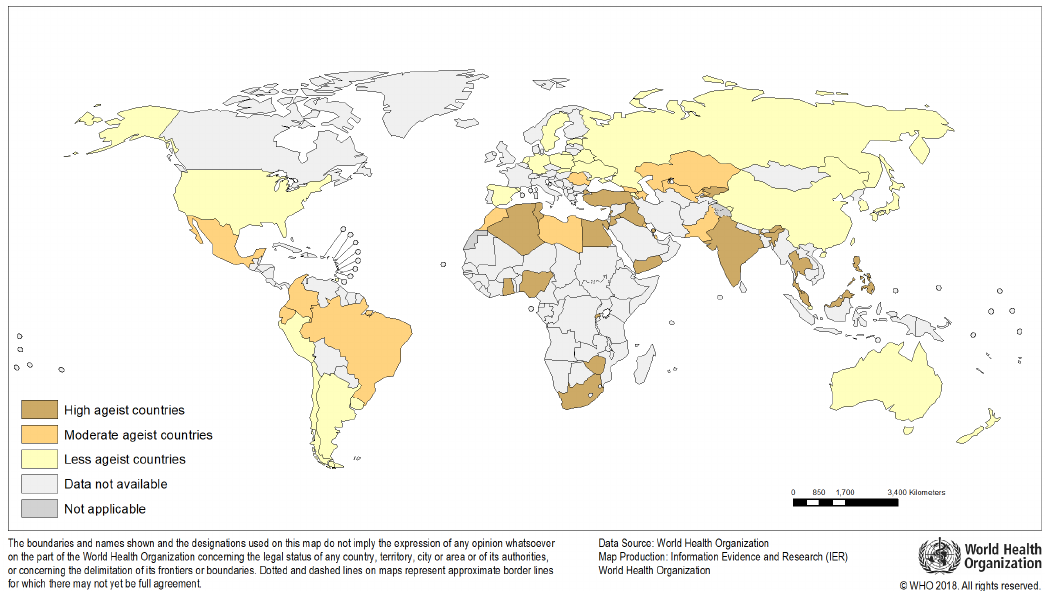
Figure 3. Distribution of Level 2 latent class membership across 57 countries.